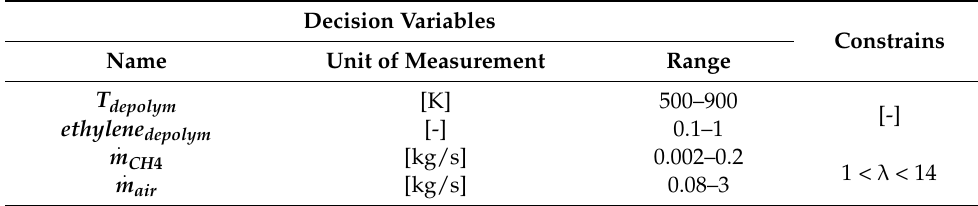
Table 5. Decision